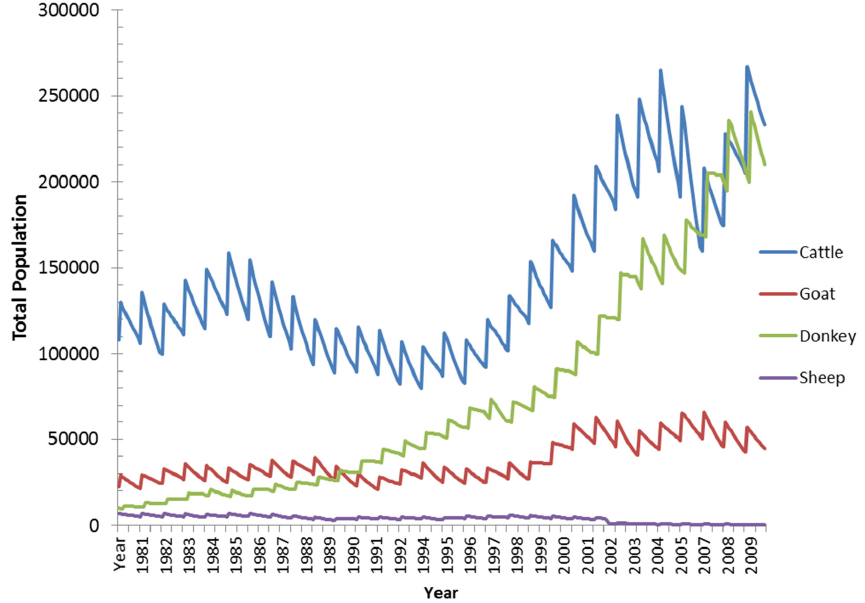
Figure 13. Simulated livestock populations for the Nkayi district in the historical scenario.